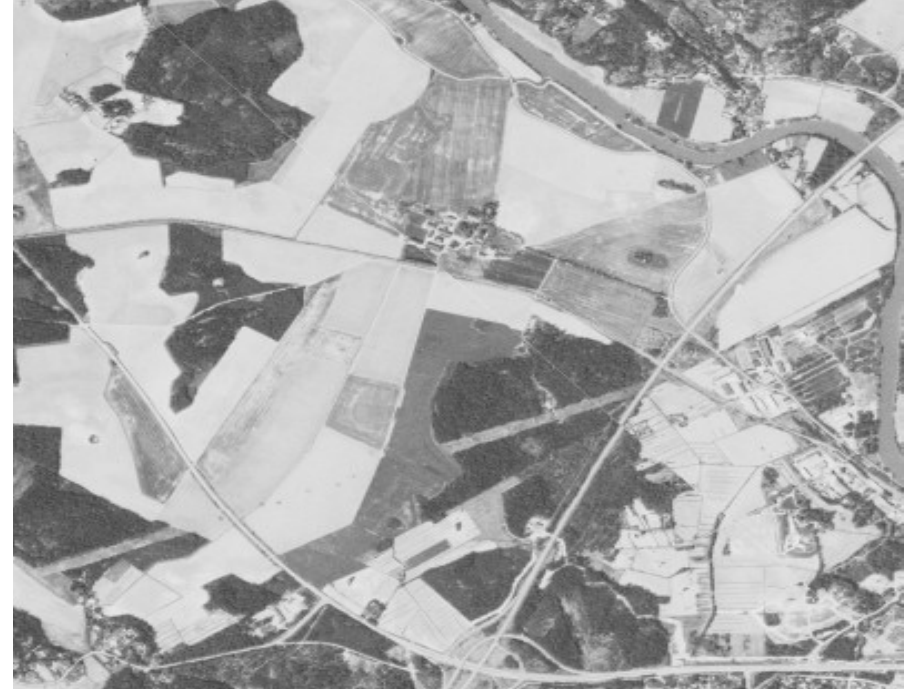
Figure 5. Landsat/TM satellite image from the Porvoo field experimental area. The image location was used for optical Landsat, SPOT and microwave HUTSCAT measurements. Porvoo River on the right corner of the